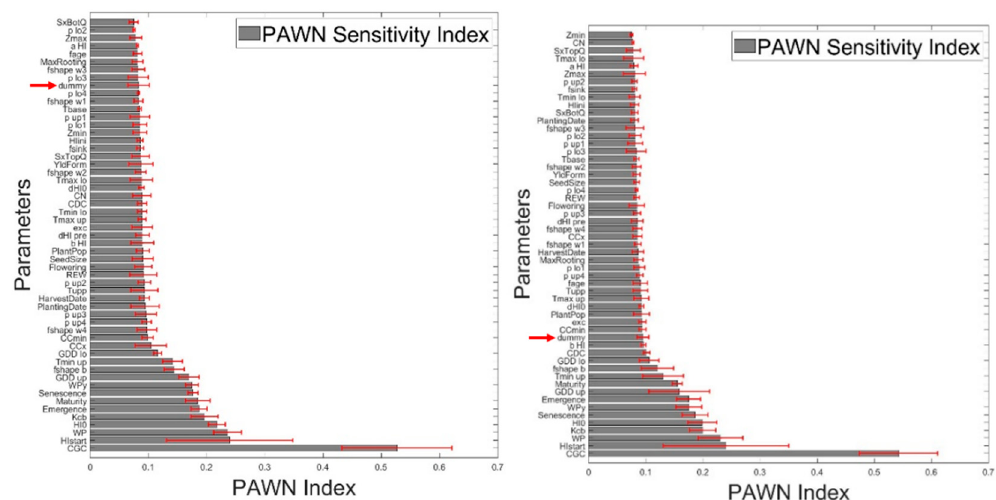
Figure 8. Average T i using the PAWN method Maccarese test site (left) and Xiaotangshan test site (right). The error bars in red represent the extreme values of T i . The dummy parameter is highlighted with the red arrow.